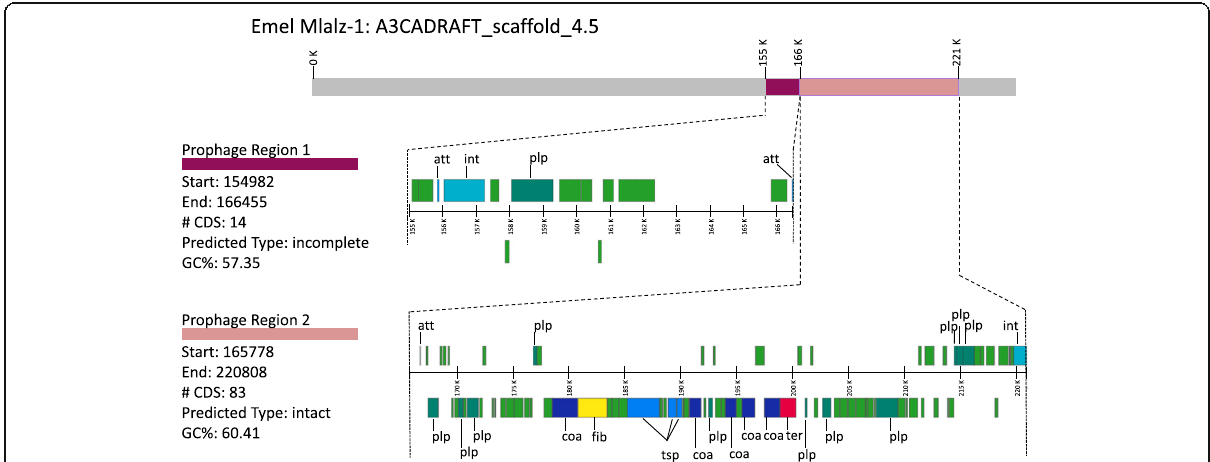
Fig. 4 Resident prophages present in Ensifer meliloti Mlalz-1 A3CADRAFT_scaffold_4.5, imaged using PHASTER [44]. Reference locus tag for Prophage Region 1 is A3CADRAFT_01439 (phage capsid family); reference locus tag for Prophage Region 2 is A3CADRAFT_01472 (prophage tail length tape measure protein). Prophage maps not drawn to scale. Attachment site (att), coat protein (coa), fiber protein (fib), integrase (int), phage-like protein (plp), tail shaft protein (tsp), and terminase (ter). All other genes encode hypothetical